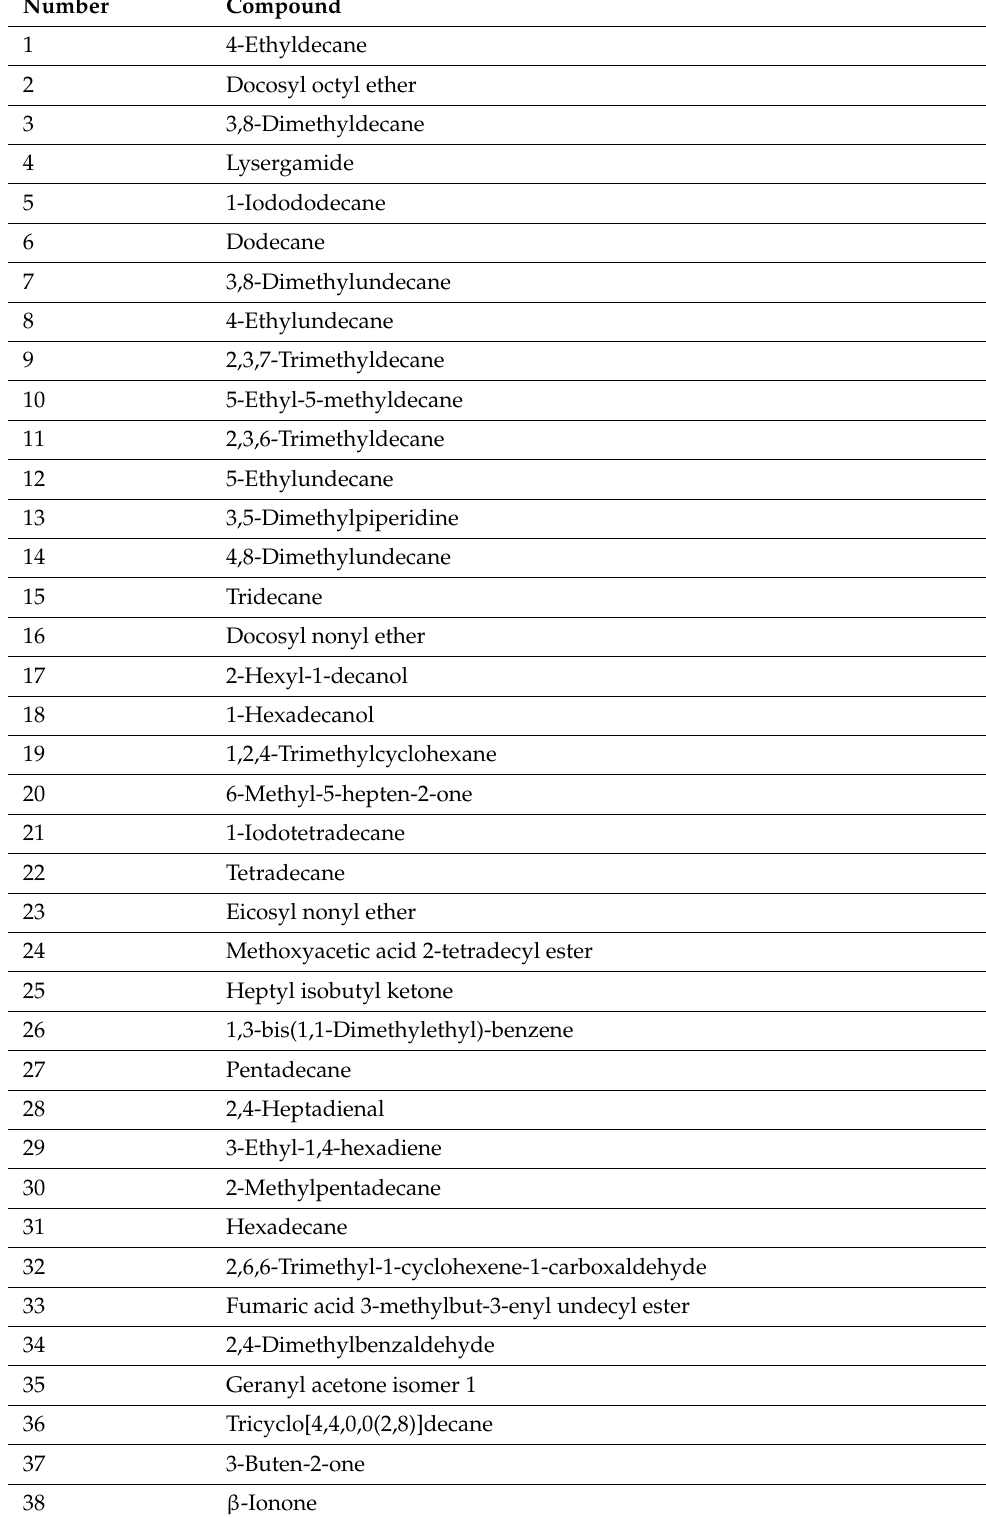
Table 2. Legend for Figure 1 presenting list of compounds numbered on the